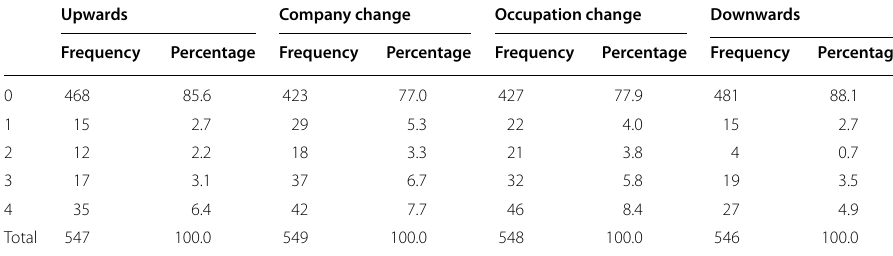
Table 9 Response frequency for different drop-out